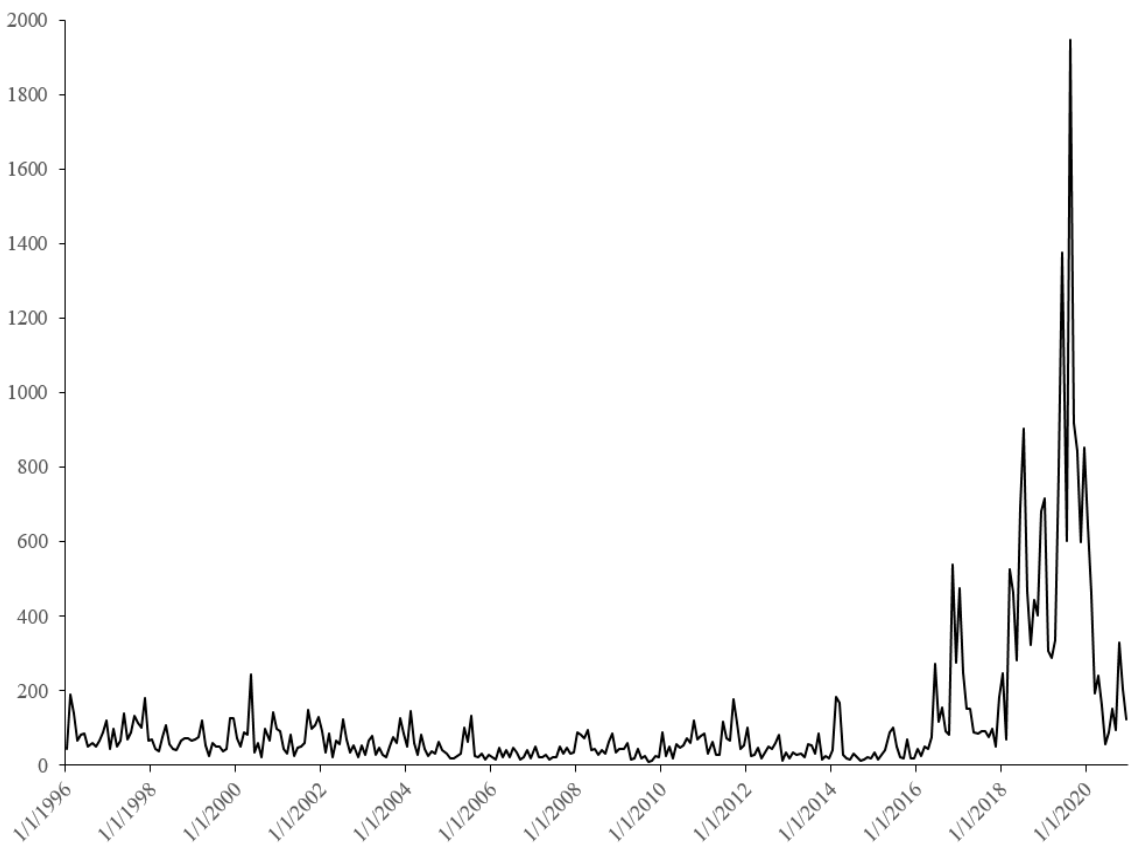
Figure 6. Trade policy uncertainty index of the United States, January 1996 to December 2020.